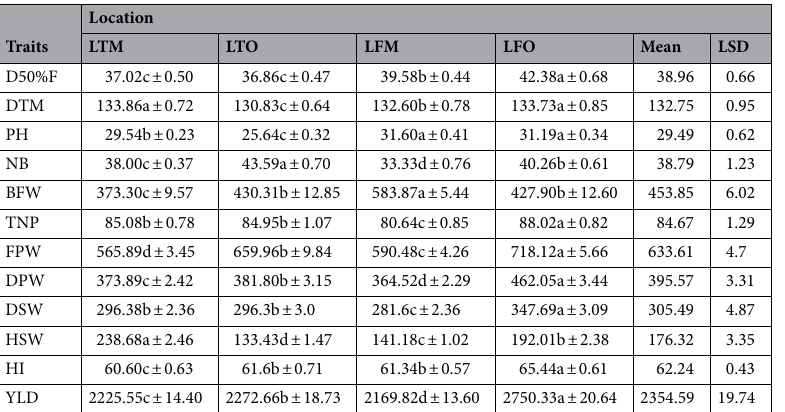
Table 5. Overall mean performance of vegetative, yield, and yield component traits of 30 V. subterranea genotypes across the environments. LTM = Ladang ten (main season), LTO = Ladang ten (off season), LFM = Ladang fifteen (main season), LFO = Ladang fifteen (off season), LSD = least significant difference (p = 0.05). Within a row, values with different letters indicate that the traits performed differently in the environments evaluated with LSD test at p > 0.05. D50%F = days to 50% flowering, DTM = days to maturiity, PH = plant height (cm), NB = number of branches , BFW = biomass fresh weight (g), TNP = total number of pods, FWP = fresh pods weight (g), DPW = dry pods weight (g), DSW = dry seeds weight (g), HSW = hundred seed weight (g), HI = harvest index, and YLD = yield